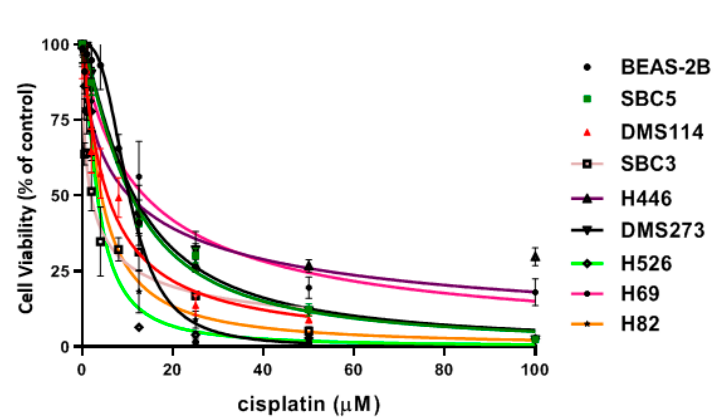
Figure 6. Cytotoxicity of SCLC cell lines to mdivi-1 and cisplatin. SCLC and control cells in 1% serum media were treated with increasing concentrations of (a) mdivi-1 and (b) cisplatin as indicated for 72 h, and cell viability was then assessed via calcein-AM uptake, as described. The results were normalized as a percentage of the DMSO treated controls and analyzed via a sigmoidal dose response curve using Prism software (version 5.0) to calculate the EC 50 value for each drug. Three independent replicate experiments were performed for each experiment. Table 1. EC 50 value for various SCLC cell lines.